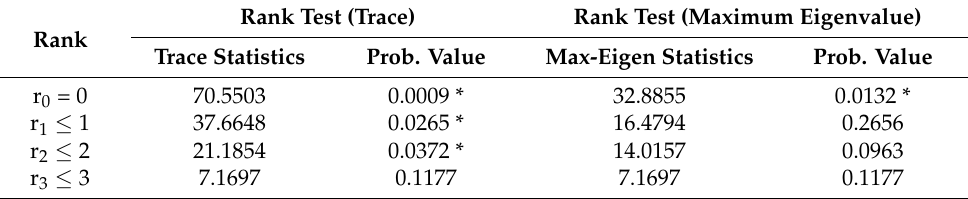
Table 6. Results of Johansen cointegration